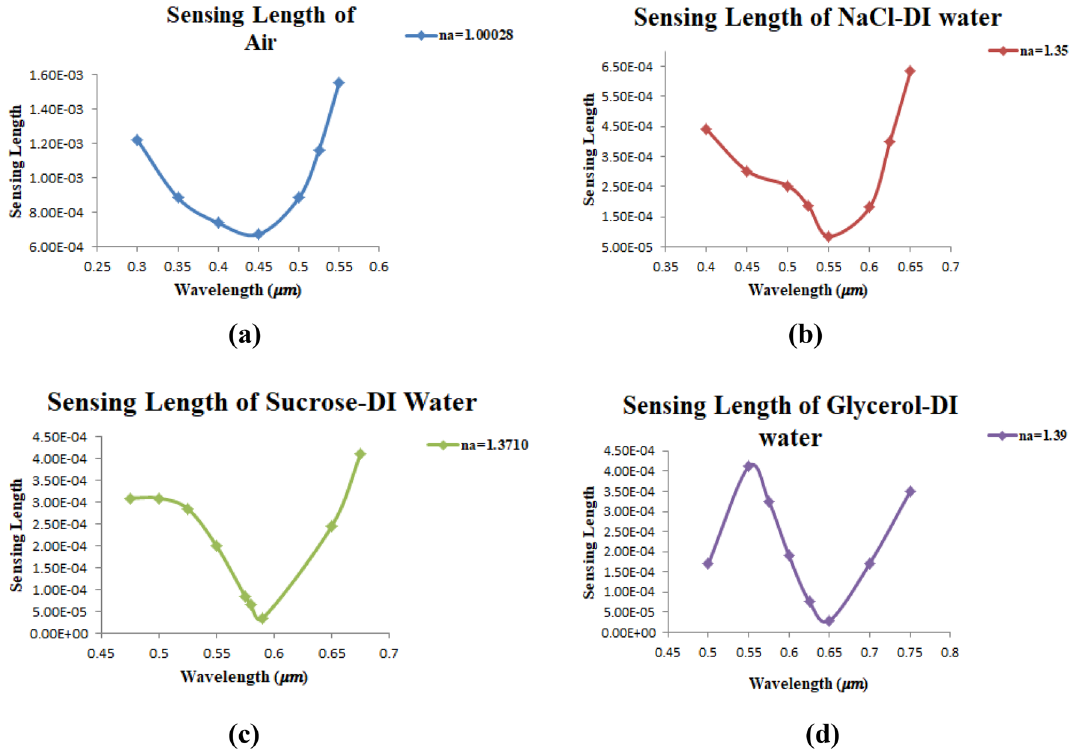
Figure 22. Presents the sensing length L s ( (cid:31) , n a ) of air, NaCl-DI water, sucrose-DI water, glycerol-DI water as a function of